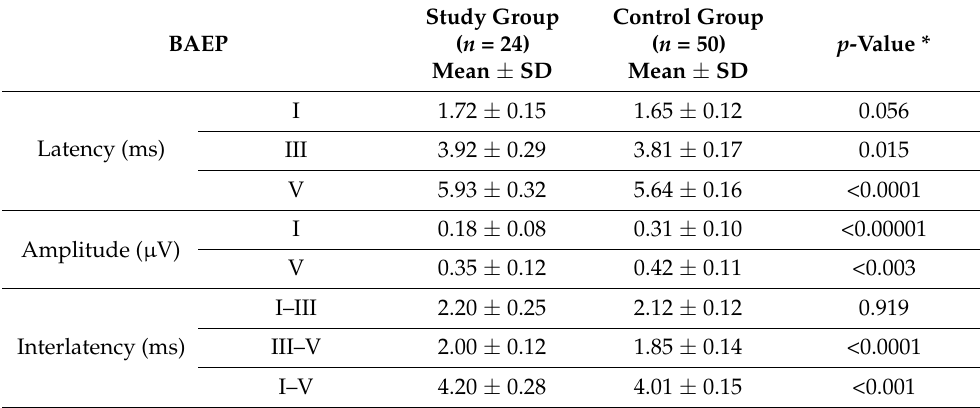
Table 2. BAEP parameters in myasthenia gravis patients and in the control group.